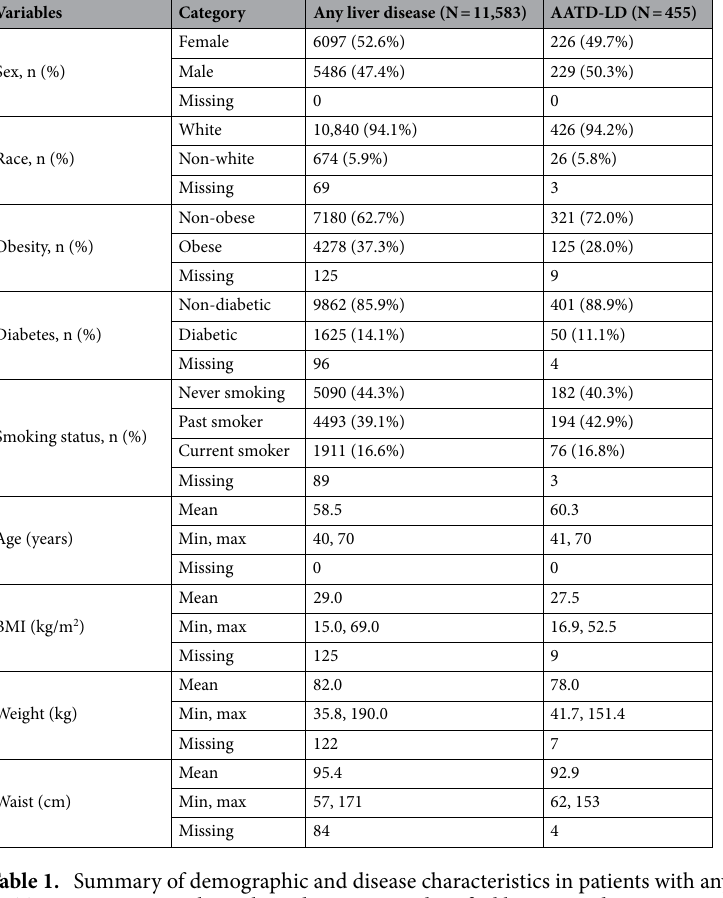
Table 1. Summary of demographic and disease characteristics in patients with any liver disease and AATD-LD. Patients with any liver disease were identified by ICD code. Patients with AATD-LD is a subset of patients with any liver disease.